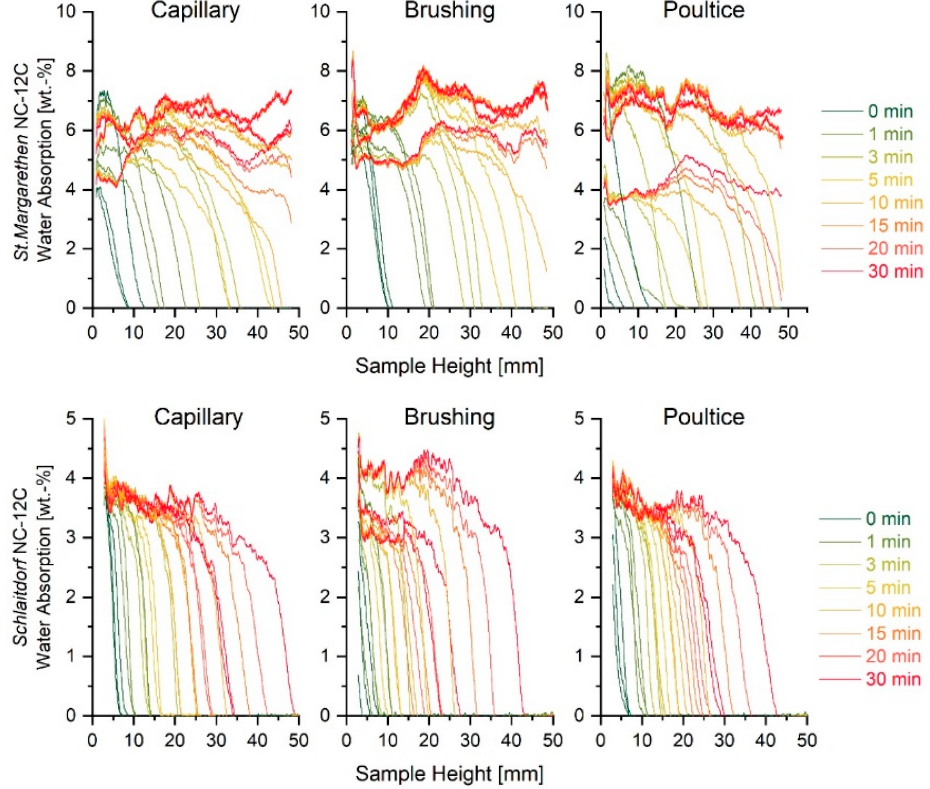
Figure 9. The top graph displays water absorption kinetics reported in weight percentage for St. Margarethen Limestone treated with NC-12C, while the bottom graph displays the kinetics of water absorption by capillarity for Schlaitdorf Sandstone, also treated with